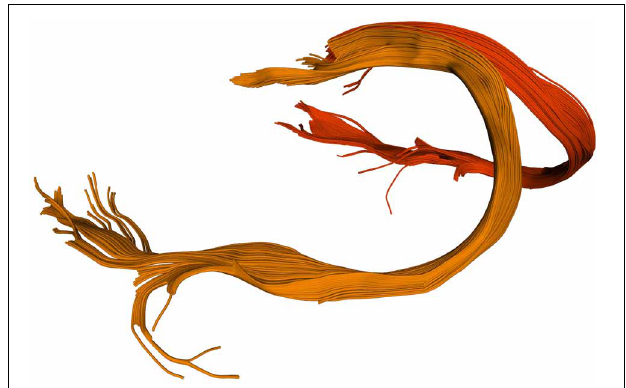
FIGURE 1 | The fornix is a C-shaped bundle connecting the hippocampus with the hypothalamus. The body of the fornix divides into two legs knows as the crus of the fornix. We can see here a detailed recreation of the fornix using dMRI data processed with